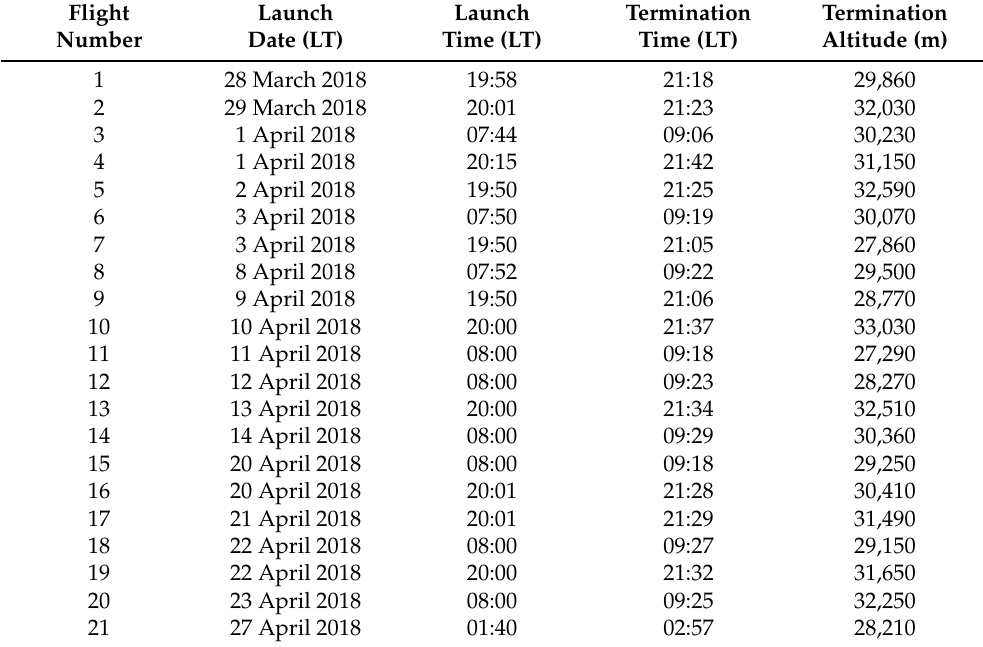
Table 2. A total of 21 results of the balloon-borne microthermal measurement field campaigns at Haikou marine environment site from March to April in 2018. The height a.g.l, launch date, time, and termination time are listed (note: the date and time reported were the local date and